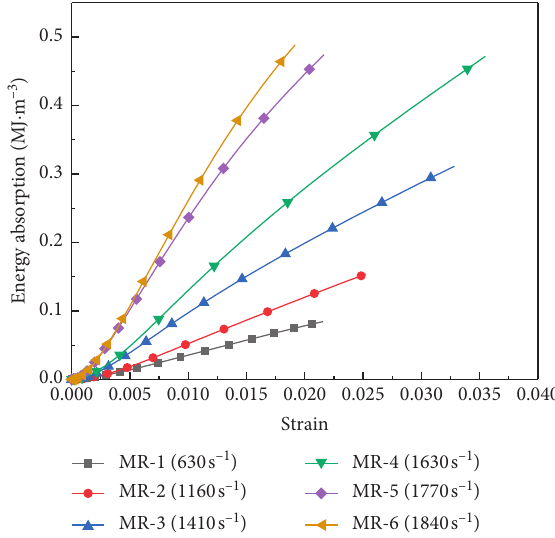
Figure 7: Q − ε curves.